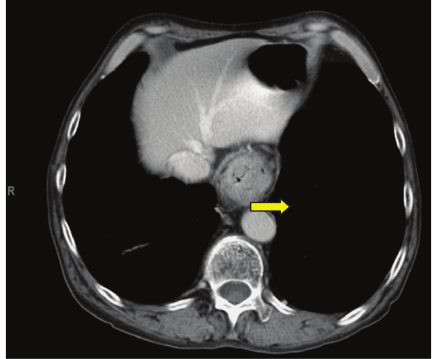
Figure 5: CT of chest showing a near-obstructing mass in the distal esophagus (yellow